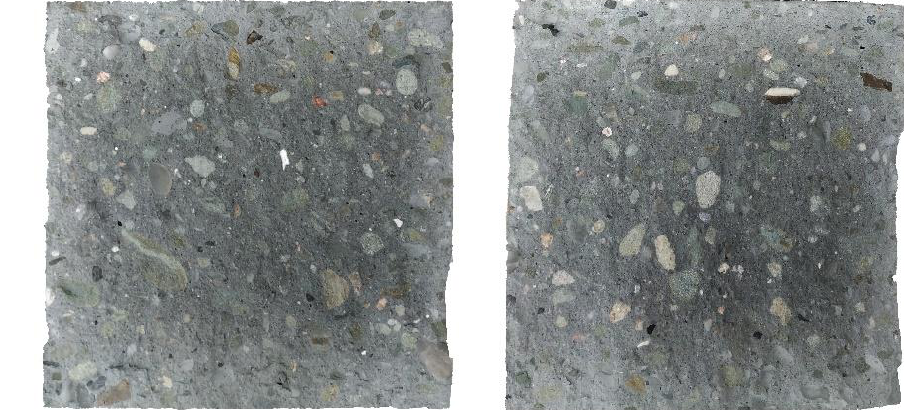
Figure 6. Examples of the surface of the first layer of specimens after splitting tensile strength tests: ( a ) Variant A; ( b ) Variant B; ( c ) Variant C.